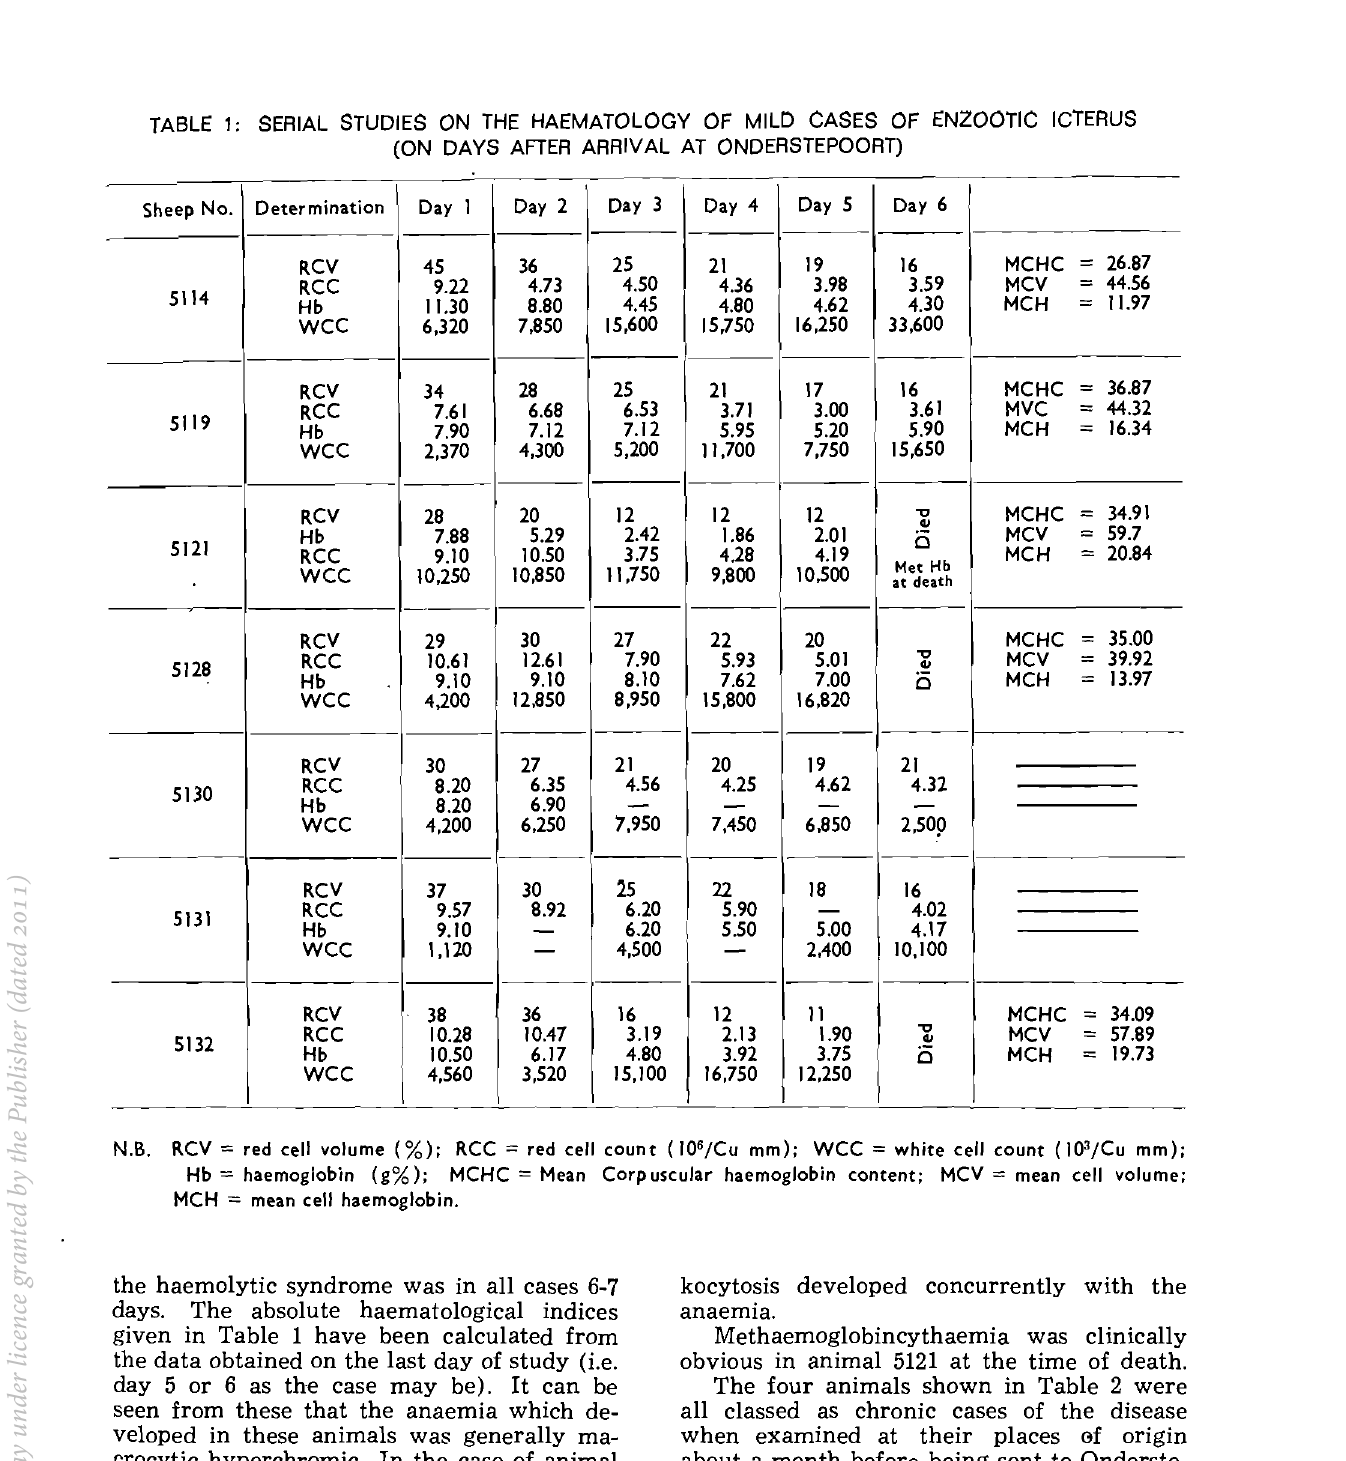
TABLE 1; SERIAL STUDIES ON THE HAEMATOLOGY OF MILD CASES OF ENZOOTIC ICTERUS (ON DAYS AFTER ARRIVAL AT ONDERSTEPOORT) Sheep No.